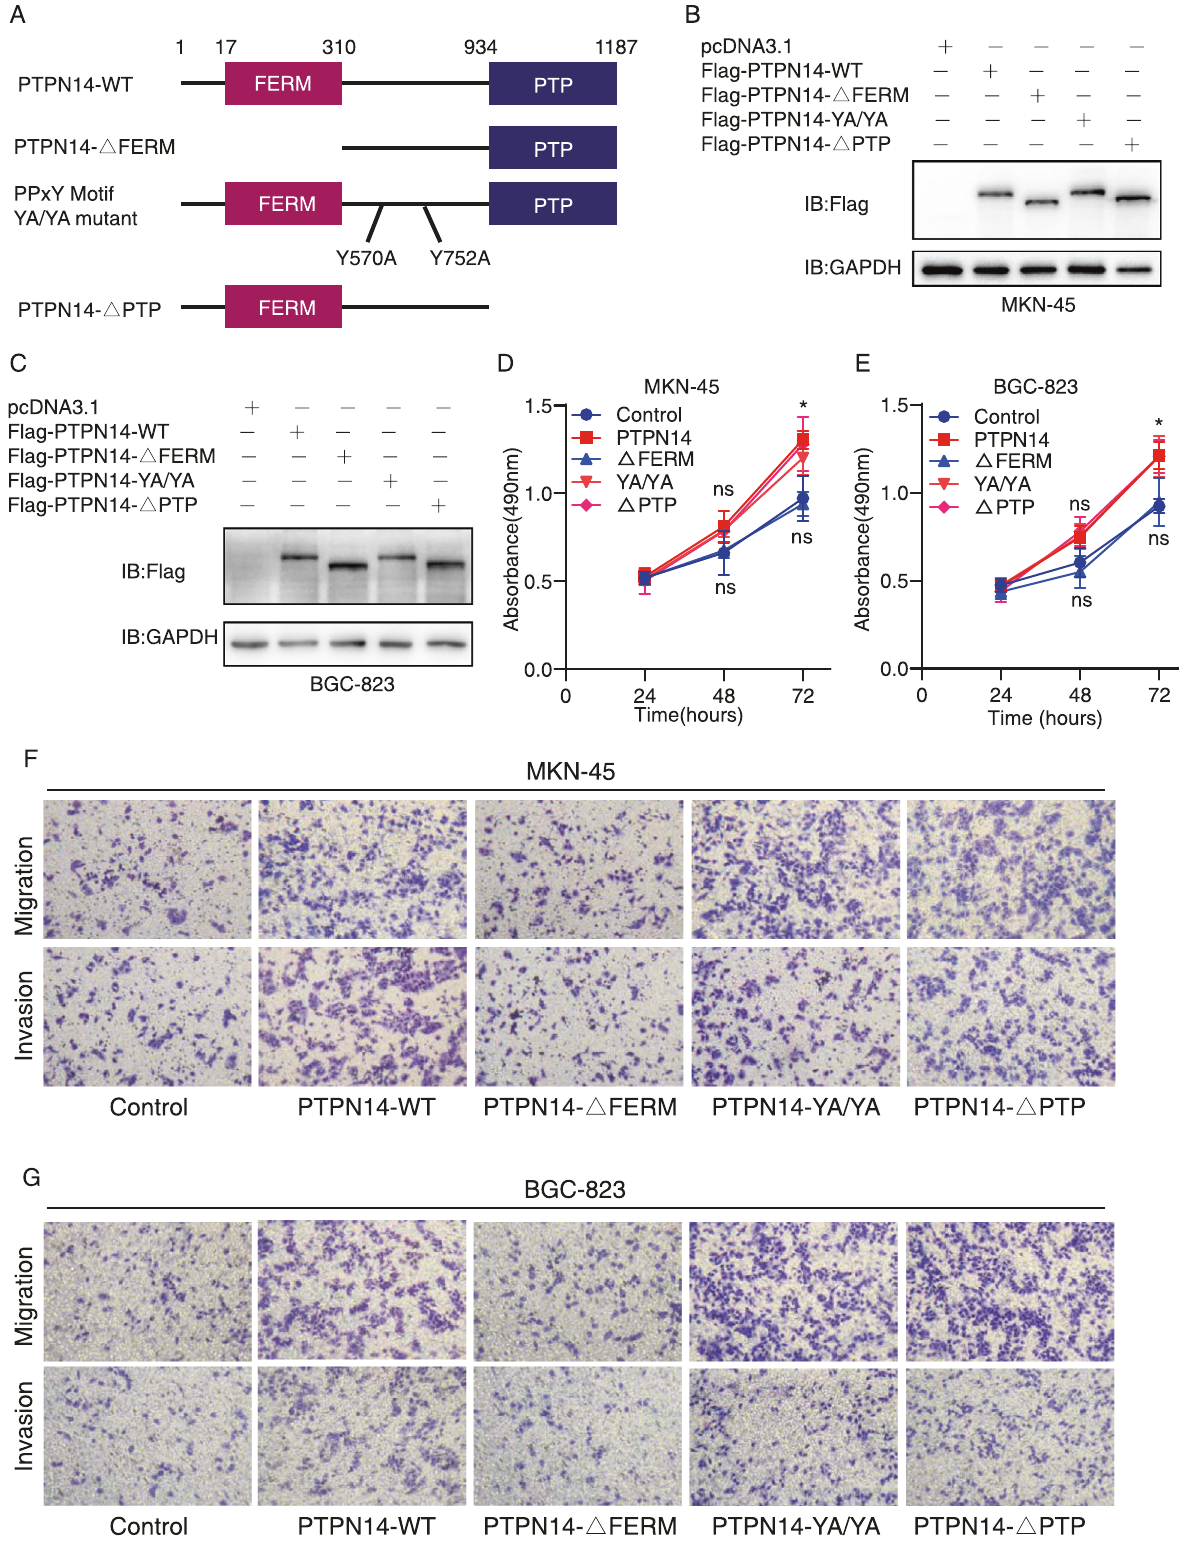
Fig. 4 PTPN14 promotes gastric cancer cell proliferation, migration, and invasion mainly through its FERM domain. A Schematic representation of PTPN14 wild-type plasmid and its truncated plasmids. B , C Western blot veri fi ed the expression of PTPN14 wild-type plasmid and PTPN14 truncated plasmids in MKN-45 cells ( B ) and BGC-823 cells ( C ). D , E CCK-8 assays indicated that PTPN14- Δ FERM diminished its ability to promote cell proliferation in MKN-45 cells ( D ) and BGC-823 cells ( E ). * p < 0.05; cells overexpressing PTPN14 wild type plasmids, YA/YA mutant plasmids or Δ PTP mutant plasmids were compared with control cells. F , G Transwell assays showed that PTPN14- Δ FERM could not prompt cell migration and invasion in MKN-45 cells ( F ) and BGC-823 cells ( G ).